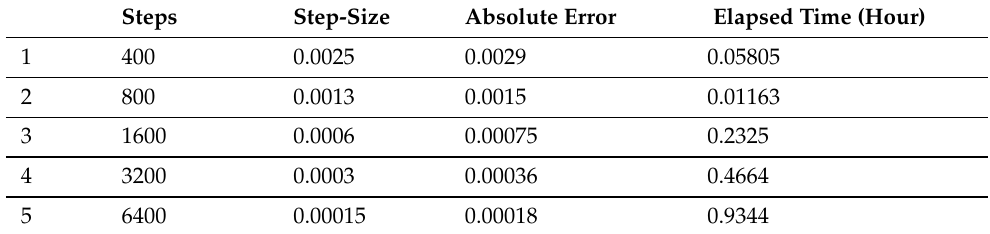
Table 2. Implementation result of approximate coupling method.